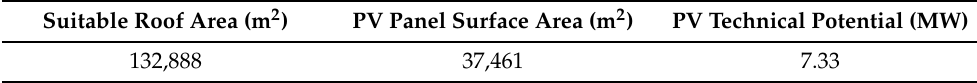
Table 13. Ustica PV technical potential on rooftops.